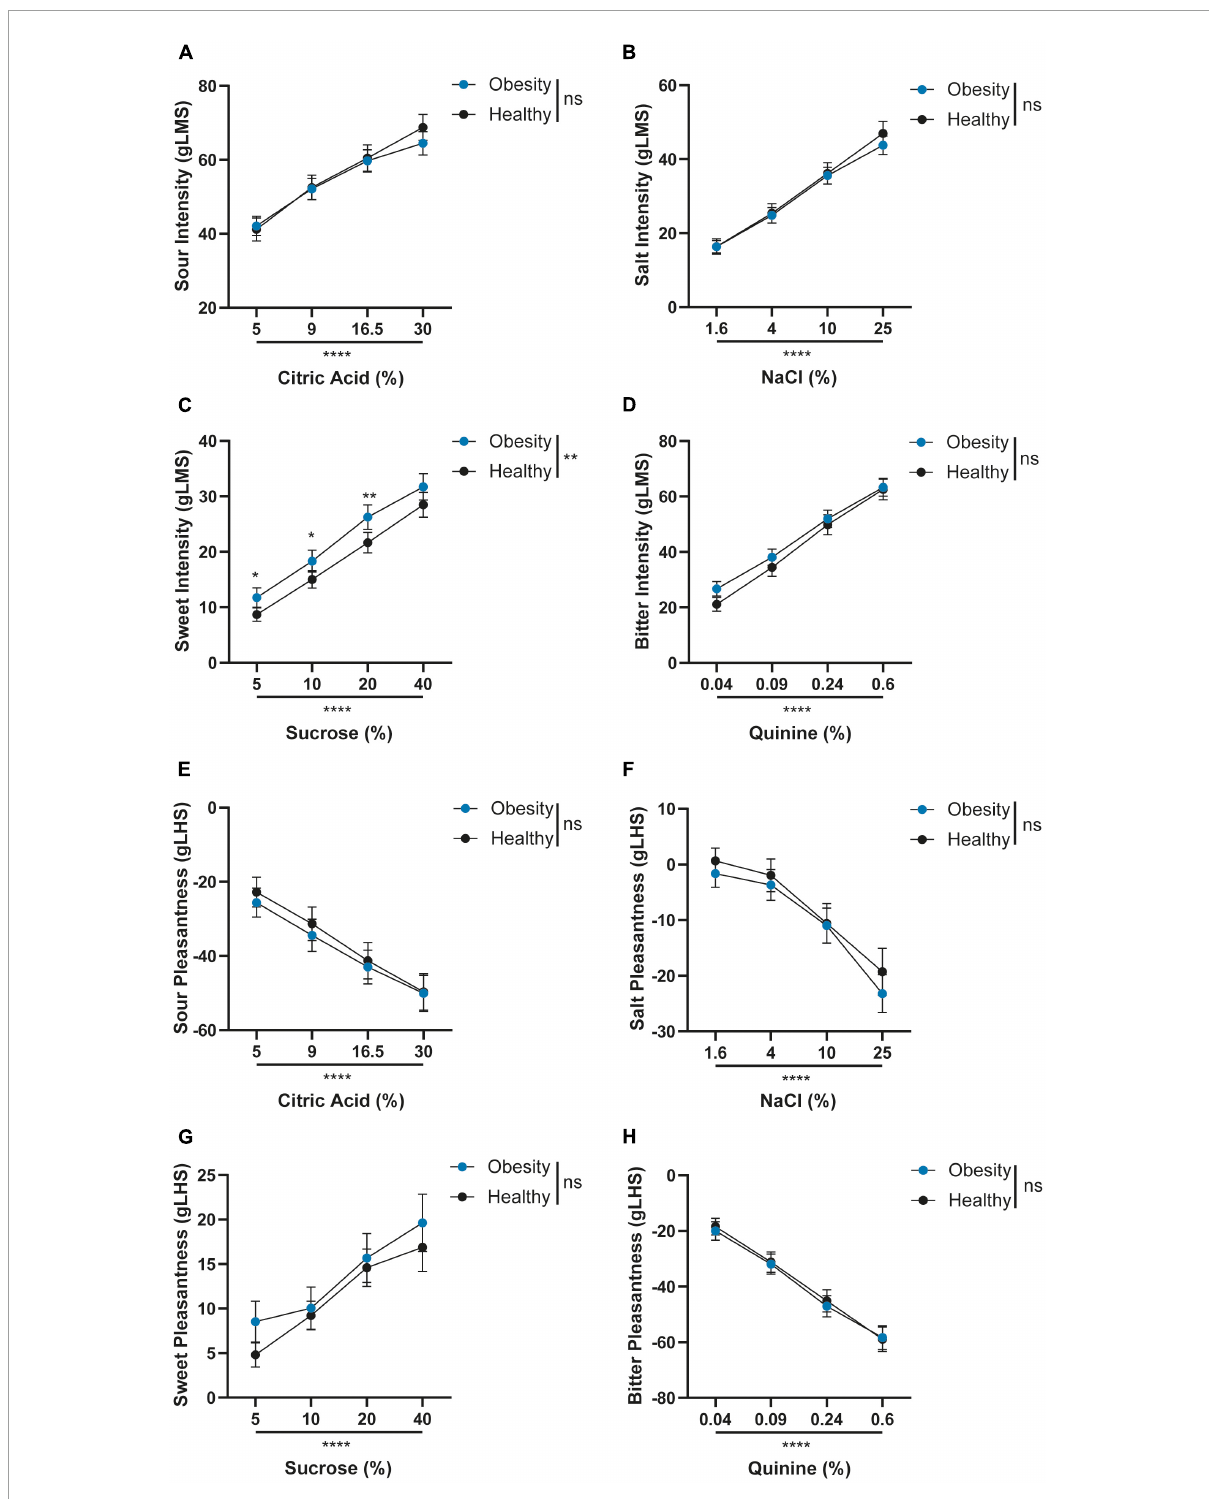
FIGURE2 (A–H) Comparison of intensity and pleasantness ratings across tastants’ concentrations between obesity and healthy groups. Graphs represent means and 95% CI. Repeated measures two-way ANOVA with the Geisser Greenhouse correction and Bonferroni’s multiple comparison’s test were computed for each comparison. ns: P > 0.05; ** P ≤ 0.01; and **** P ≤ 0.0001; Obesity, N = 230; and Healthy, N = 166. gLMS, general Labeled Magnitude Scale; gLHS, general Labeled Hedonic